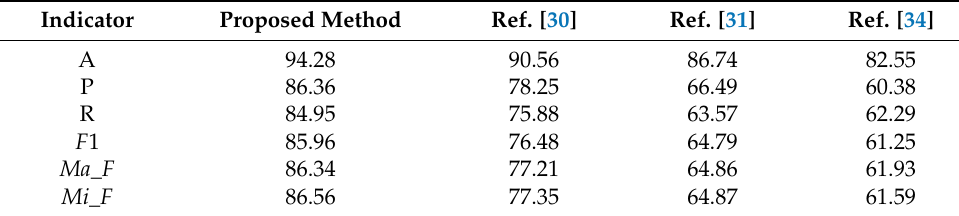
Table 4. Comparison of evaluation indicators of different